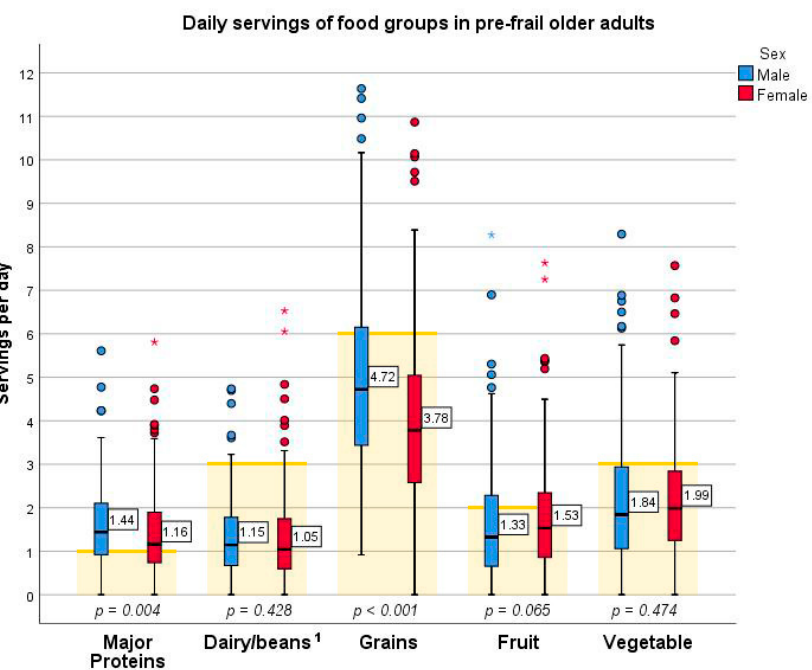
Figure 2. Box and whisker plot depicting daily servings of food groups consumed by pre-frail older adults by sex and overlaid on corresponding serving recommendations. Note: p -values represent differences between males and females and were determined by independent samples tests. Yellow bars represent recommended servings from New Zealand guidelines [31]. 1 Beans have been grouped with dairy based on the DQI-I food group structuring based on calcium content [22] whereas the recommended three servings was set for dairy alone [31]. Each asterisk (*) represents an extreme outlier to the data, for example, two female participants consumed over seven servings of fruit a day and one male participant consumed over eight servings of fruit a day.